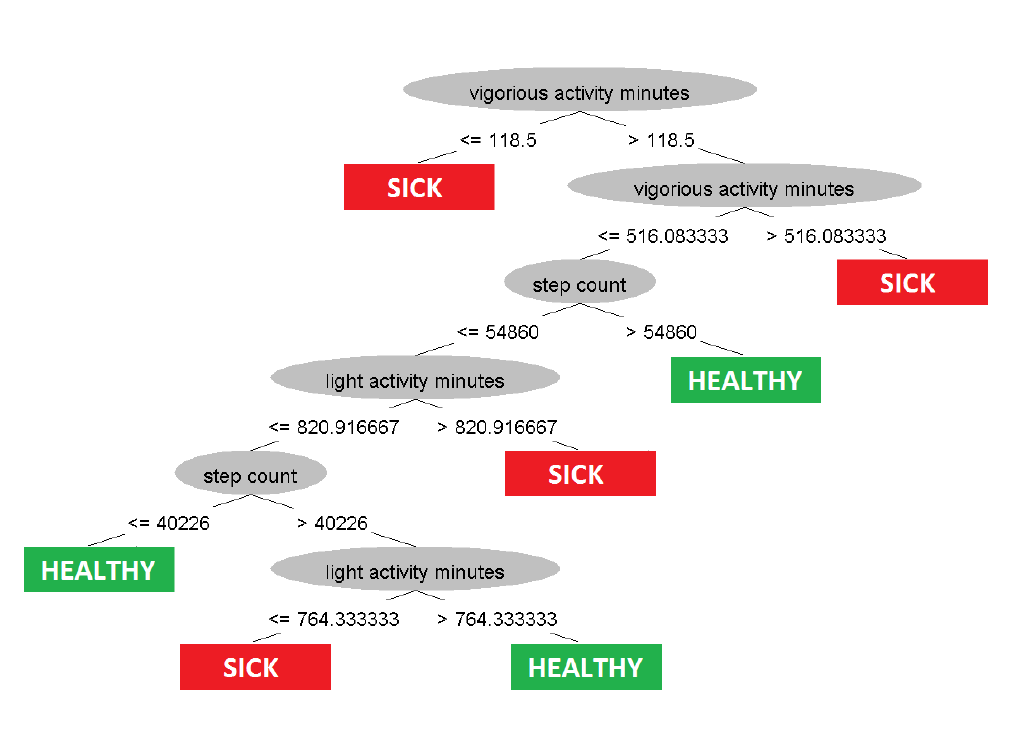
Figure 2. J48 tree